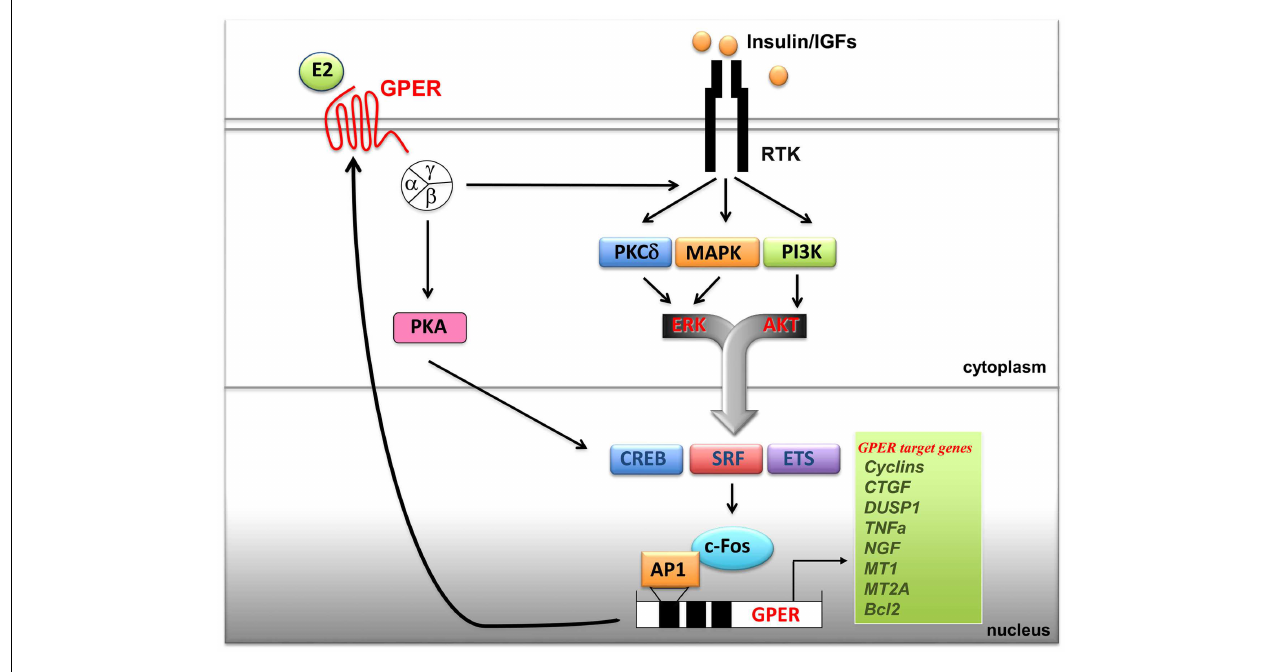
FIGURE 1 | Cross-talk between GPER and the IGF system . Upon binding to their specific tyrosine kinase receptors (RTKs), insulin and IGF-I stimulate rapid signals converging on the activation of PI3K, MAPK and PKC δ networks.These pathways, in turn, trigger the activation of transcription factors including CREB, SRF and ETS, which favor c-fos induction and its recruitment to the AP-1 site located next to the GPER 5’ flanking region.Transactivation of GPER promoter sequences induces GPER upregulation at both mRNA and protein levels and, as a consequence, enhanced transcription of GPER target genes. In turn, GPER, upon estrogens binding, activates heterotrimeric G proteins, which trigger multiple effectors including PKA, and also PKC δ , MAPK and